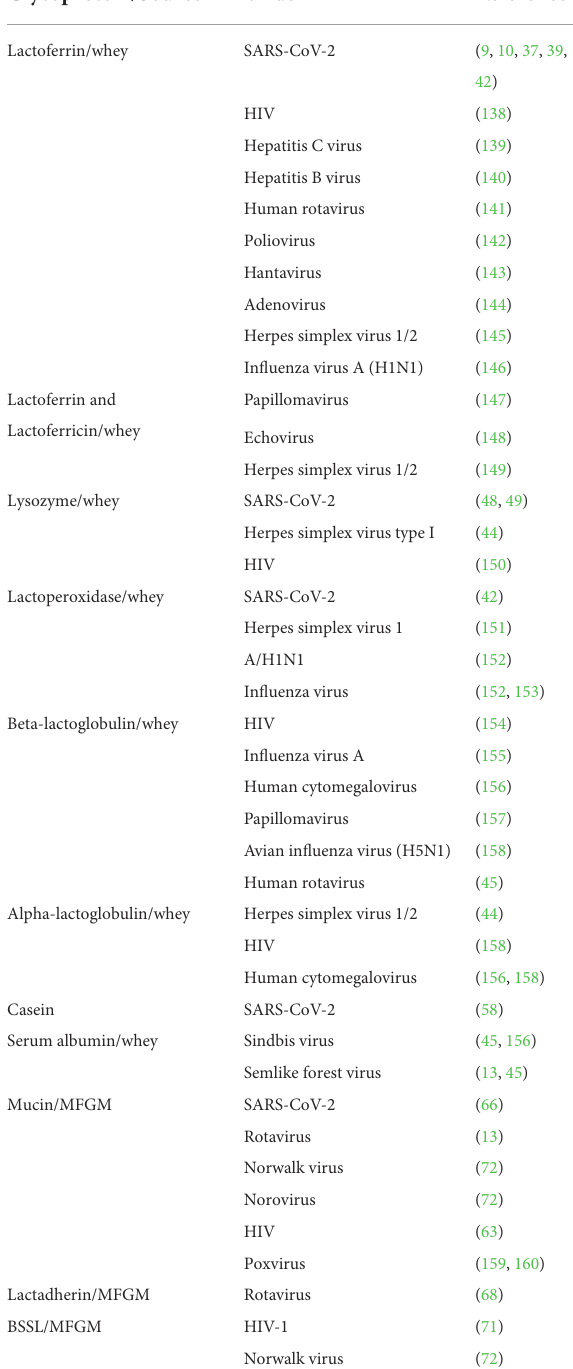
TABLE 1 Some antiviral milk